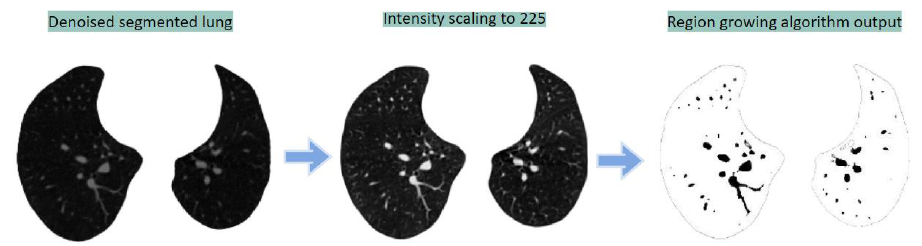
Figure 21. Region-growing-based segmentation process.